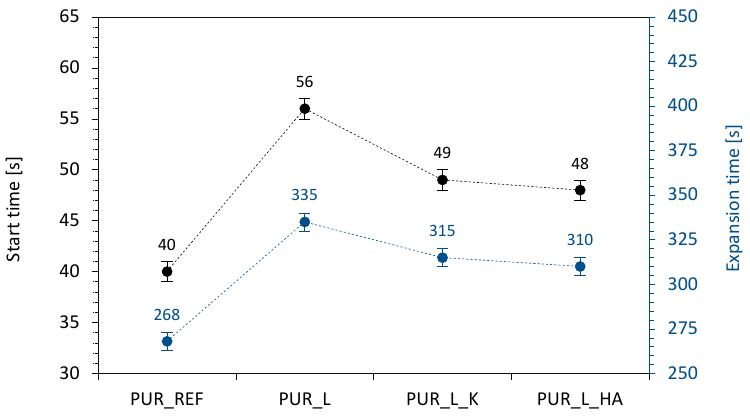
Figure 4. The results of start time and expansion time measured for PUR systems. The impact of lavender filler addition on the cellular morphology of PUR composites was evaluated by SEM. As presented in Figure 5a,b, PUR_REF shows the typical, polyhedral structure with a high content of closed-cells. When lavender fillers are added to the PUR systems, an average size of closed-cells tends to be smaller, which is connected with a nucleating effect of the added fillers. The average size of cells decreases from 485 µ m (for PUR_REF) to 470, 450, and 455 µ m for PUR_L, PUR_L_K, and PUR_L_HA, respectively. According to the SEM results, the incorporation of non-functionalized lavender filler results in the formation of PUR composites with a higher number of open-cells—the content of closed-cells decreases from 87.2 to 85.4% (Figure 5c,d). This may be connected with poor compatibility between the surface of filler particles and the PUR matrix, which results in rupturing and collapsing of the PUR structure and opening of the cells, which in turn, weakens the final structure of PUR composites. The addition of lavender fillers functionalized with kaolinite and hydroxyapatite compounds results in the production of PUR composites with a little more regular structure when compared with PUR composites filled with non-functionalized lavender filler (Figure 5e–h). When compared with PUR_REF, the content of closed-cells increases from 87.2% to 87.9 and 88.2% for PUR_L_K and PUR_L_HA, respectively. This result indicates that the functionalization of lavender filler using a high-energy ball milling process promotes the formation of PUR composites with a higher-crosslinking degree, which prevents the deterioration of the structure during the foaming process. This is additionally enhanced by the presence of solid particles of functionalized lavender fillers which are successfully build into the PUR structure. As discussed previously, the application of a high-energy ball milling process leads to the fracturing of the filler particles, which results in the formation of powder filler with a reduced size of the particles. Due to this, the particles easily build into the PUR matrix, forming new edges for blowing agent encapsulation and enhancing the stability of the overall cellular morphology of PUR composites. Such effect is disturbed in the case of PUR composites filled with non-functionalized lavender fillers, due to the larger size of filler particles. Previous studies have shown, that the application of the filler particles with larger diameters, results in rupturing of the cells, due to incomplete incorporation of the filler particles into the PUR matrix [55]. A similar explanation may be found in our study as well.